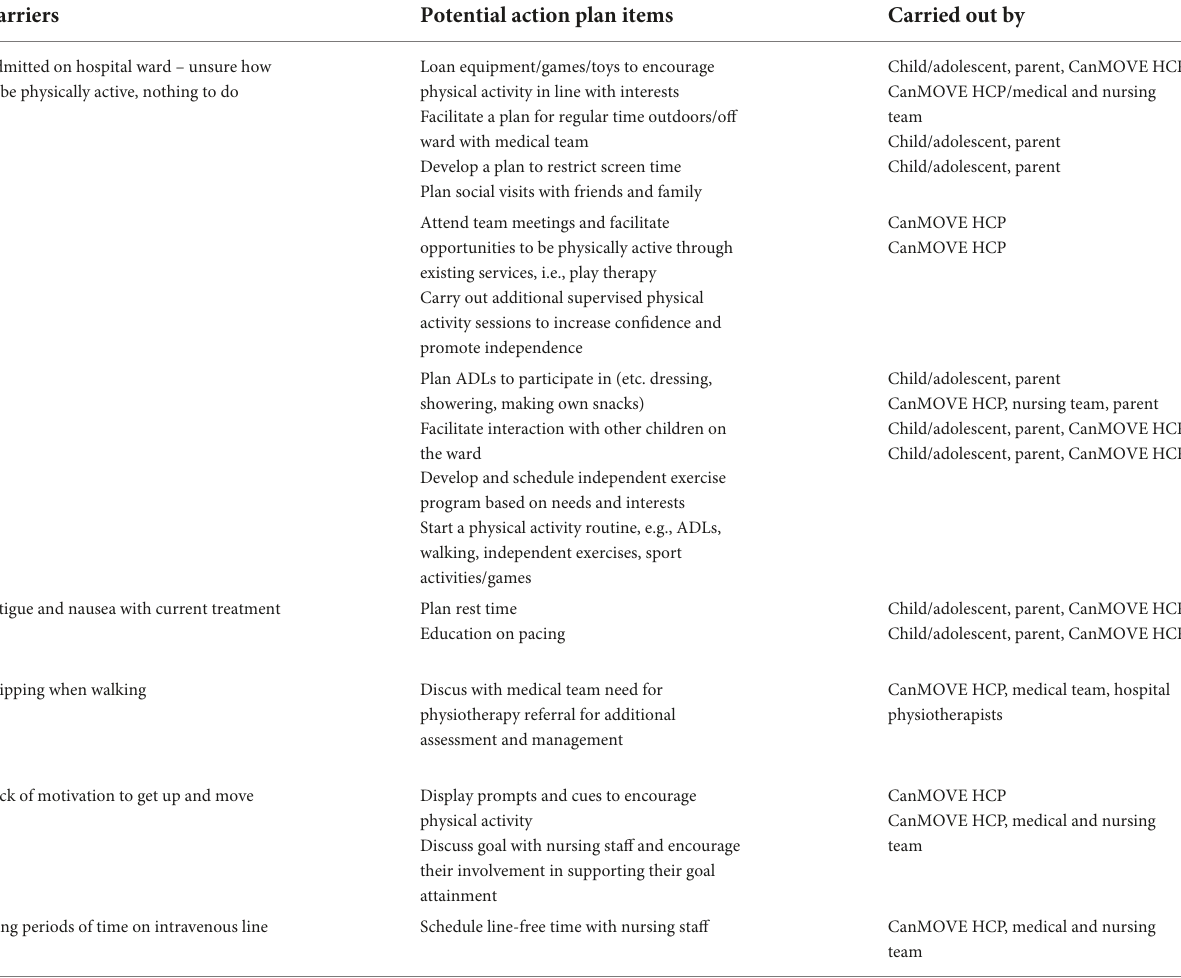
TABLE 3 Example barriers and action plan items.